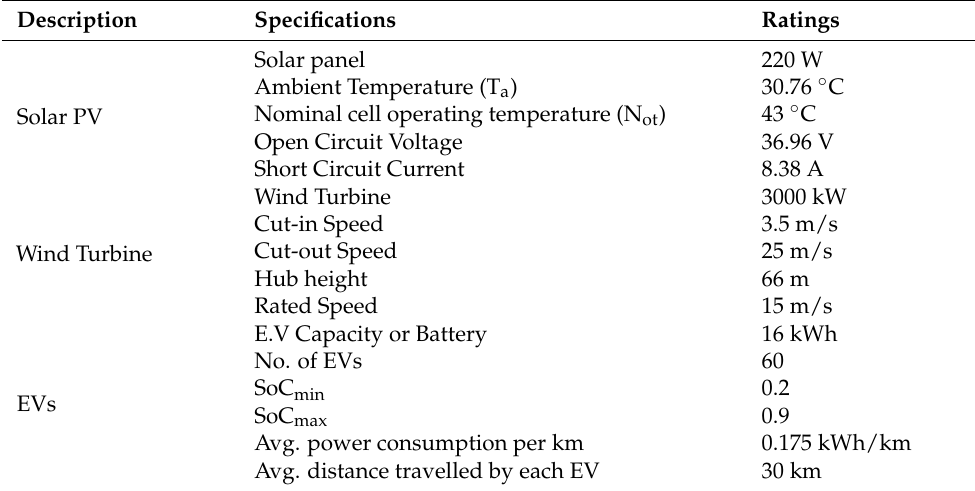
Figure 1. Characteristics of autonomous MG. Table 1. Specifications of sources